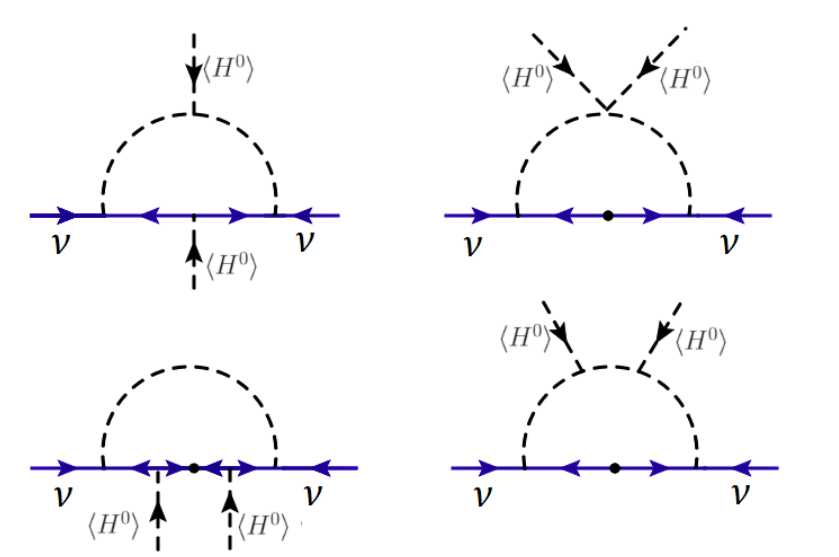
Figure 2 . Topologies of one-loop radiative neutrino mass